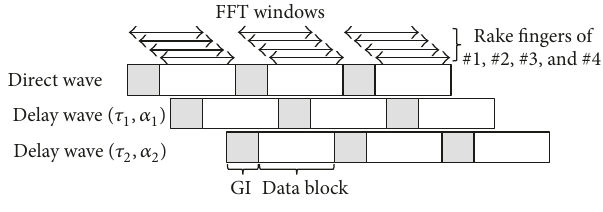
Figure 10: OFDM rake reception.